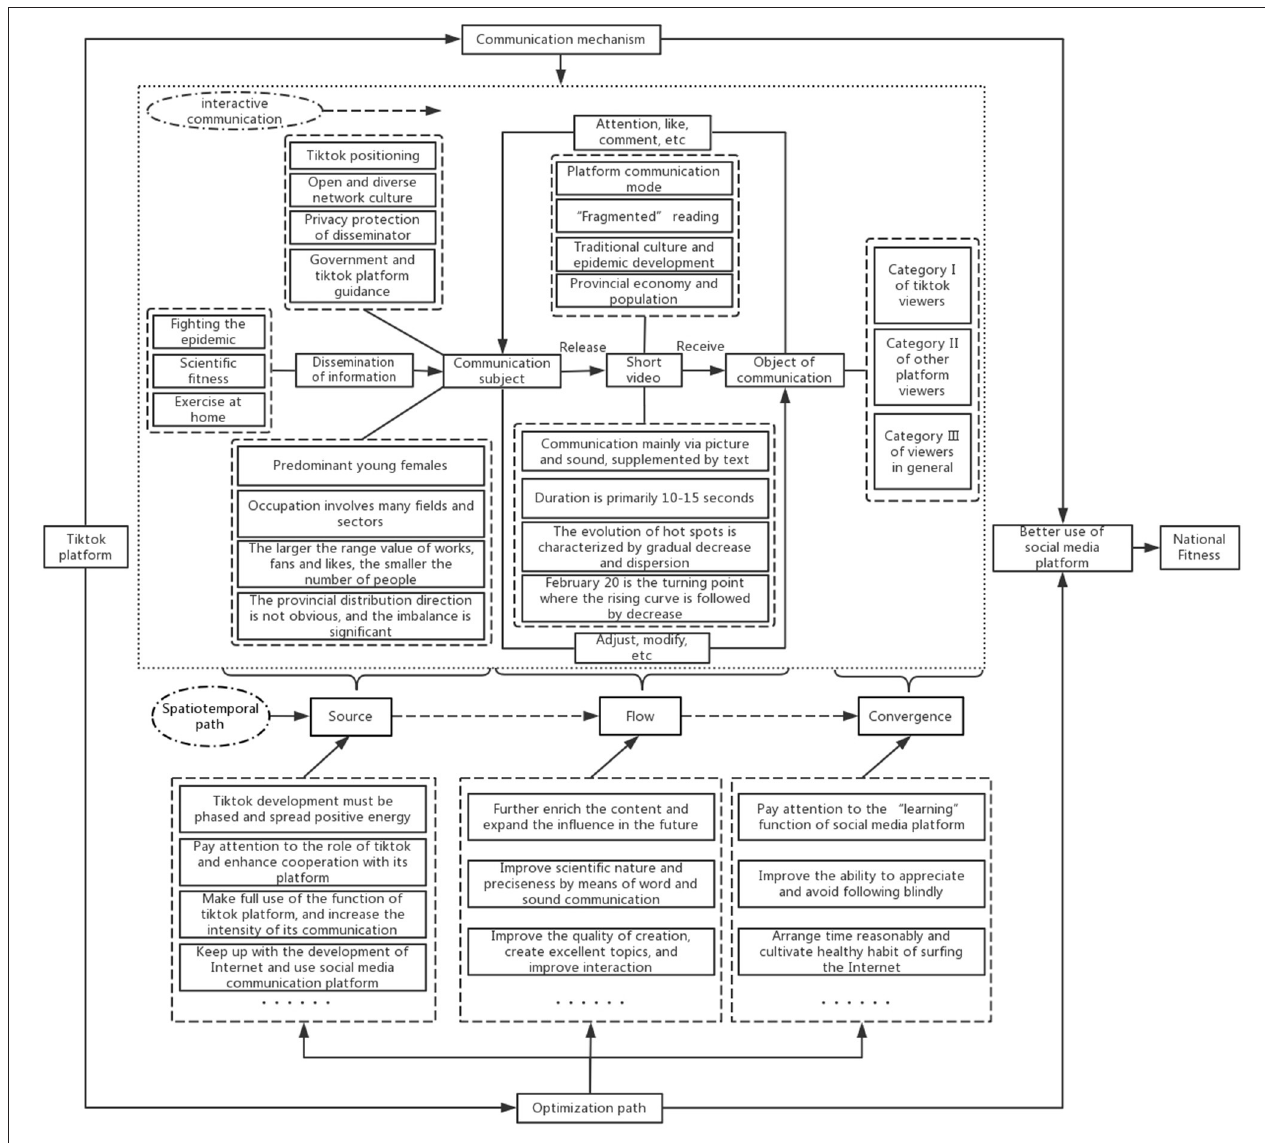
FIGURE 10 | Communication mechanism and optimization path of short fitness videos on